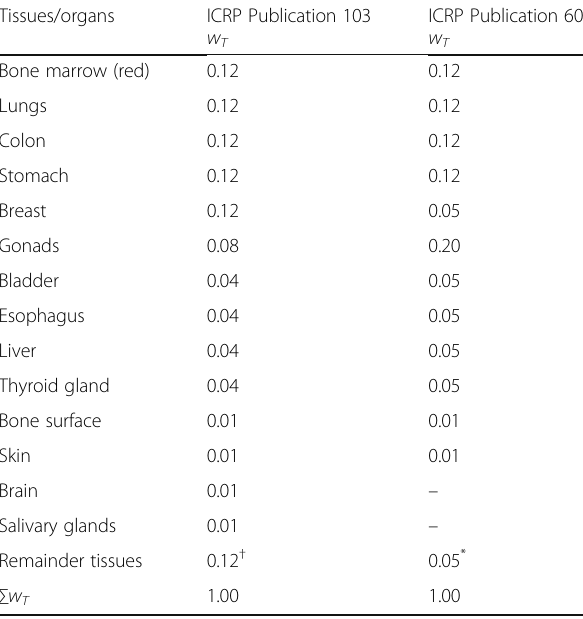
Table 1 ICRP Publication 103 [7] and ICRP Publication 60 [4] tissue weighting factors, w T